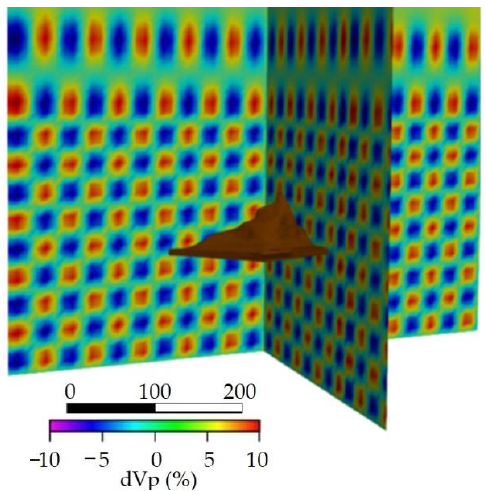
Appl. Sci. 2022 , 12 , 7265